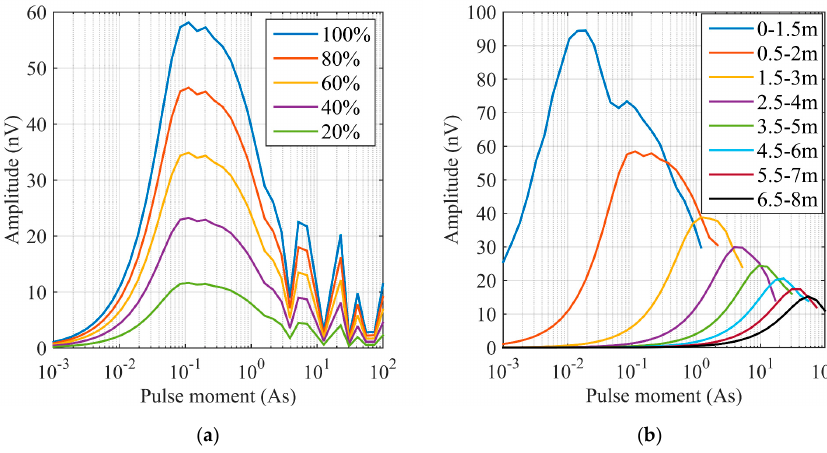
Figure 10. MRS forward modelling. ( a ) Results of the first model (the aquifer model of 1.5 m thickness is located at 0.5 m to 2 m, and the water content changes from 100% to 20%); ( b ) Results of the second model (the water content is 100% and its thickness is 1.5 m, but the position of aquifer top boundary changes from 0 m to 6.5 m).